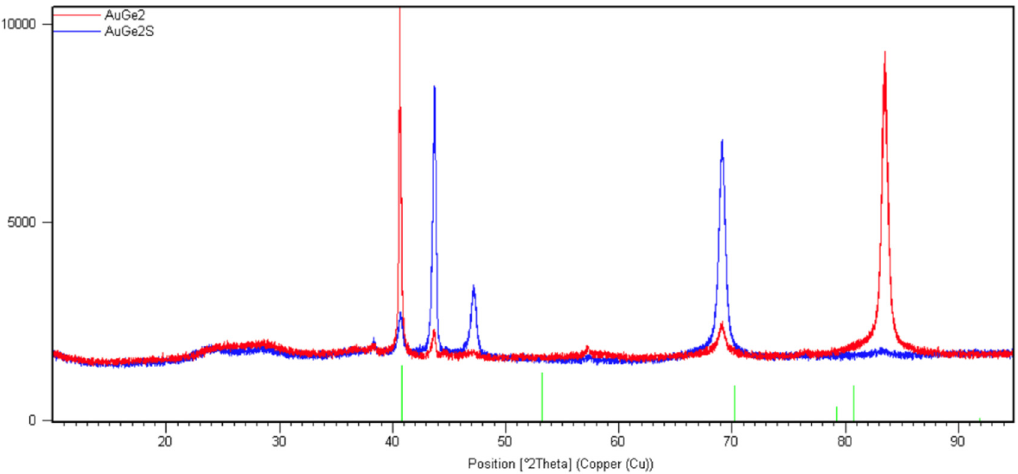
Figure 3. XRD analysis of the AuCuZnGe alloy. Green lines represents the reference line for XRD pattern of Au 0,72 Ge 0,28 (Reference code 00-047-1022) [14].